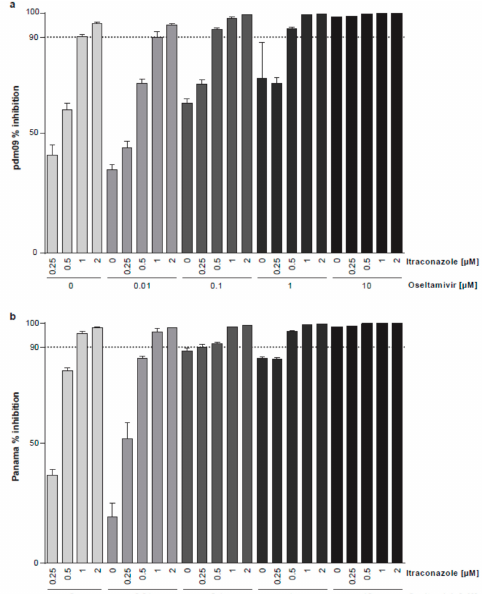
Figure 6. Analysis of the anti-IAV activity of combination treatment with oseltamivir and itraconazole. Polarized Calu-3 monolayers were infected with 0.1 MOI of ( a ) pdm09 or ( b ) Panama for 24 h. Oseltamivir and itraconazole were added at the indicated combinations 2 h p.i. Mean percentages of reduction in viral titers ± SEM, with mean virus titer in control cells (treated with the solvent DMSO) set to 100%; n = 3. Dotted line, 90% reduction in viral titer. Computation of the 95% confidence intervals of the differences between combinations and the respective single dose of oseltamivir revealed that itraconazole increased the antiviral activity in the range of 0–1 µM oseltamivir; however, the differences were less pronounced with increasing concentrations of oseltamivir (Figure 7).